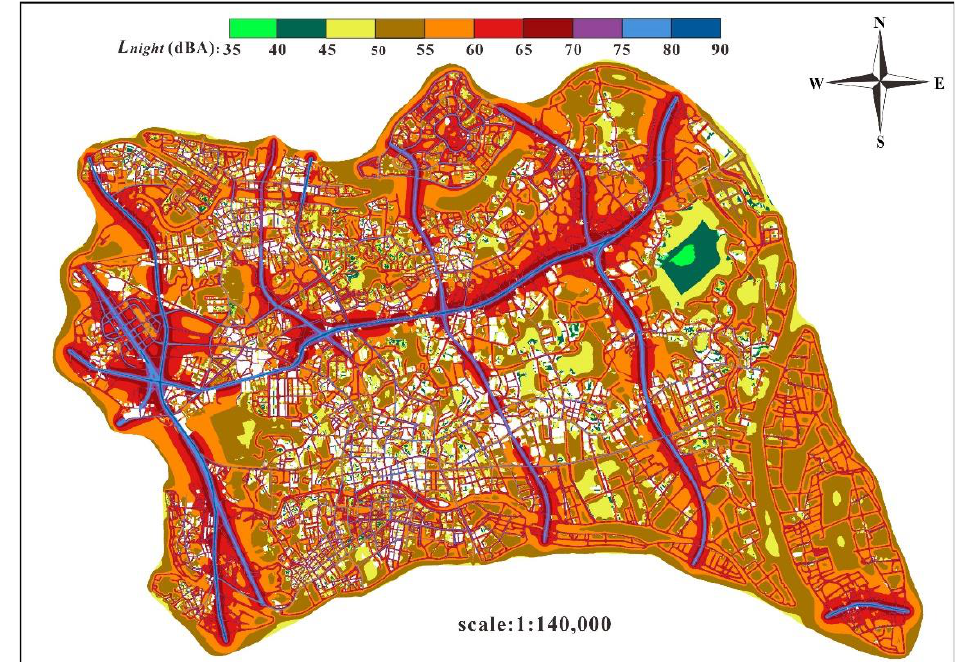
Figure 7. Nighttime urban traffic noise map of Panyu District, Guangzhou City with the existence of noise barriers. L night is the A-weighted equivalent noise level over the 8 h period of nighttime (22:00 to 6:00).